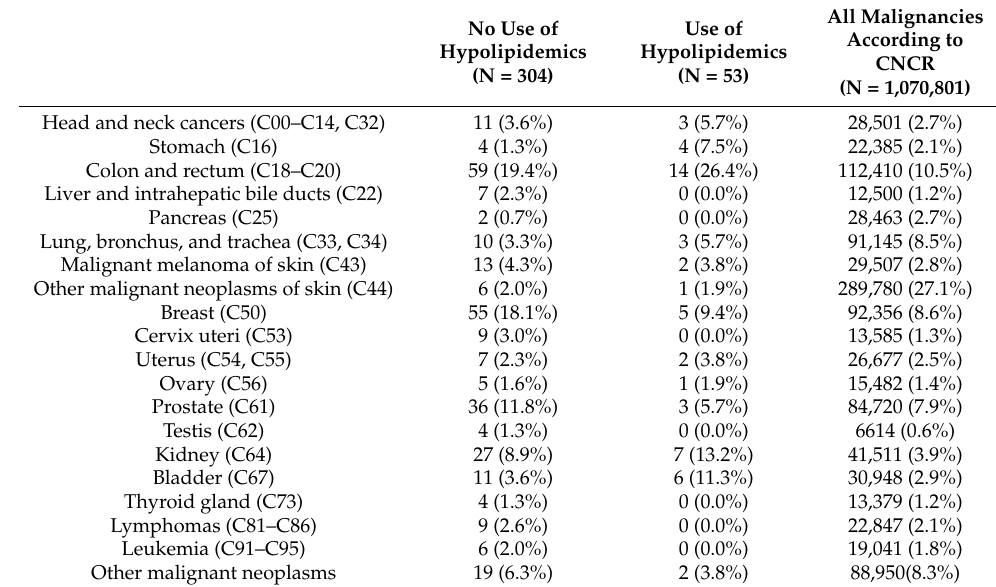
Table 6. Second primary malignancies by the site of diagnosis, stratified by the use of hypolipi- demic